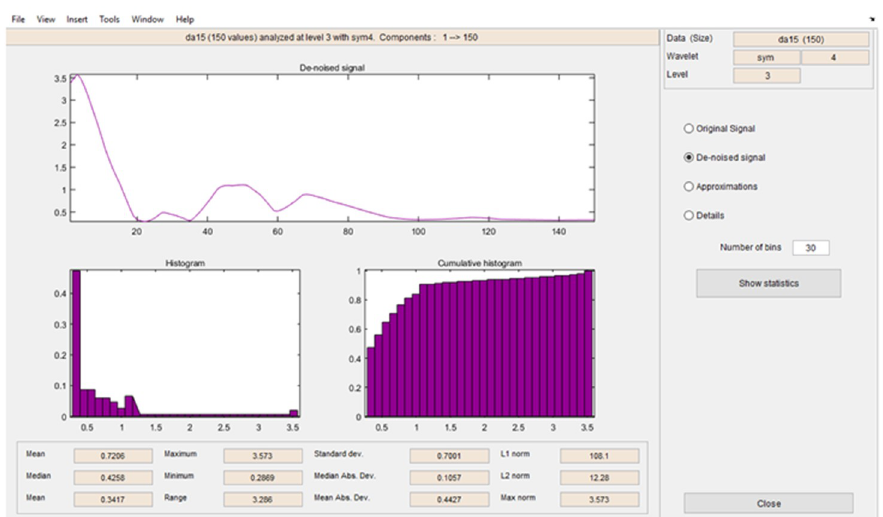
Figure 18. Statistical data of the de-noise signal of the approximation coefficients in level 3 related to the double upward movement.